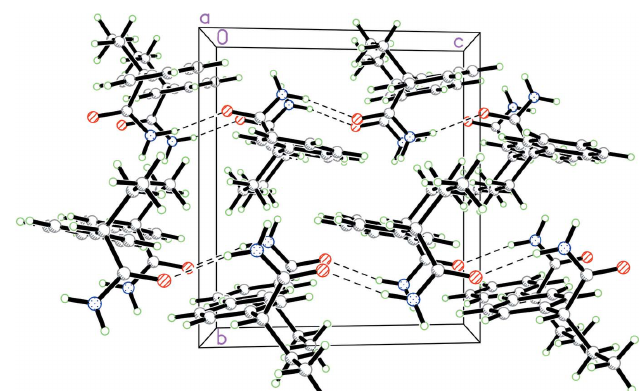
Figure 2 View of a hydrogen-bonded chain.